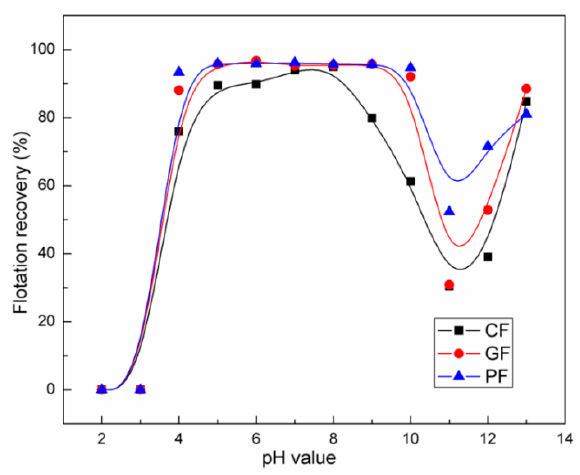
Figure 4. Flotation recovery of different colored fluorites at their optimal NaOL dosage as a function of pH.